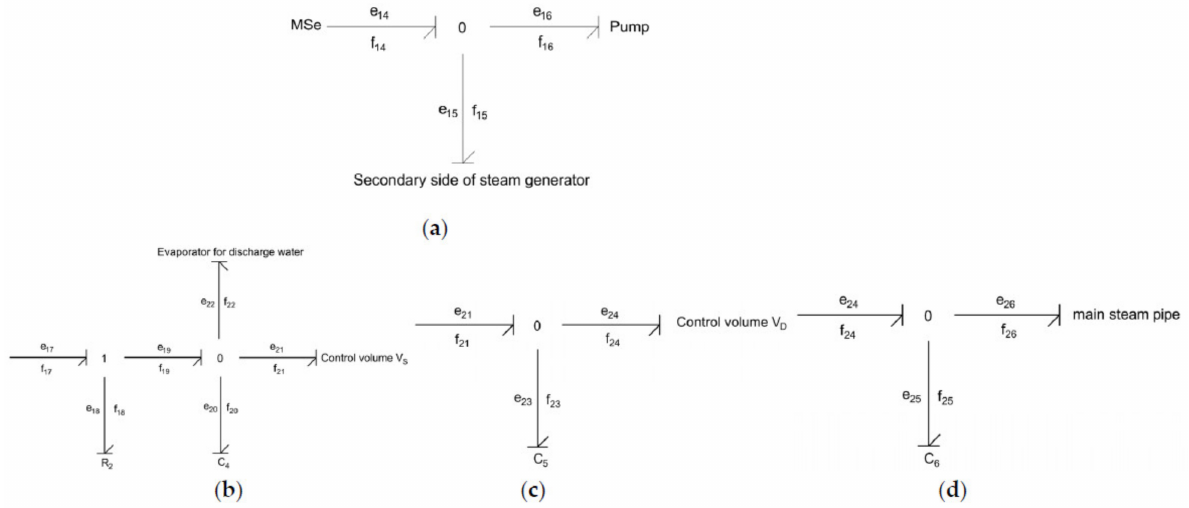
Figure 8. Bond graph model of the steam generator: ( a ) primary-side; ( b ) control volume V W ; ( c ) control volume Vs; ( d ) control volume V D